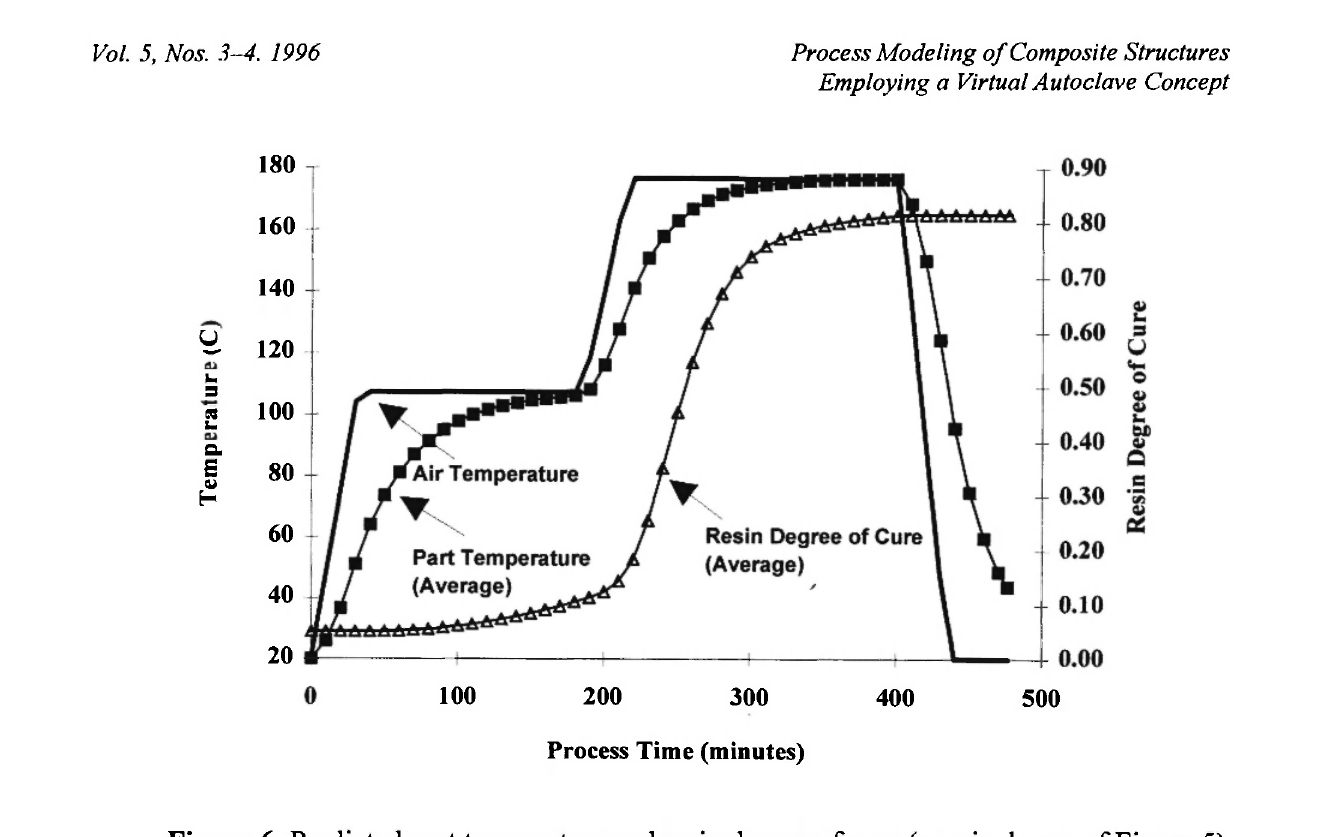
Figure 6 Predicted part temperature and resin degree of cure (nominal case of Figure 5).